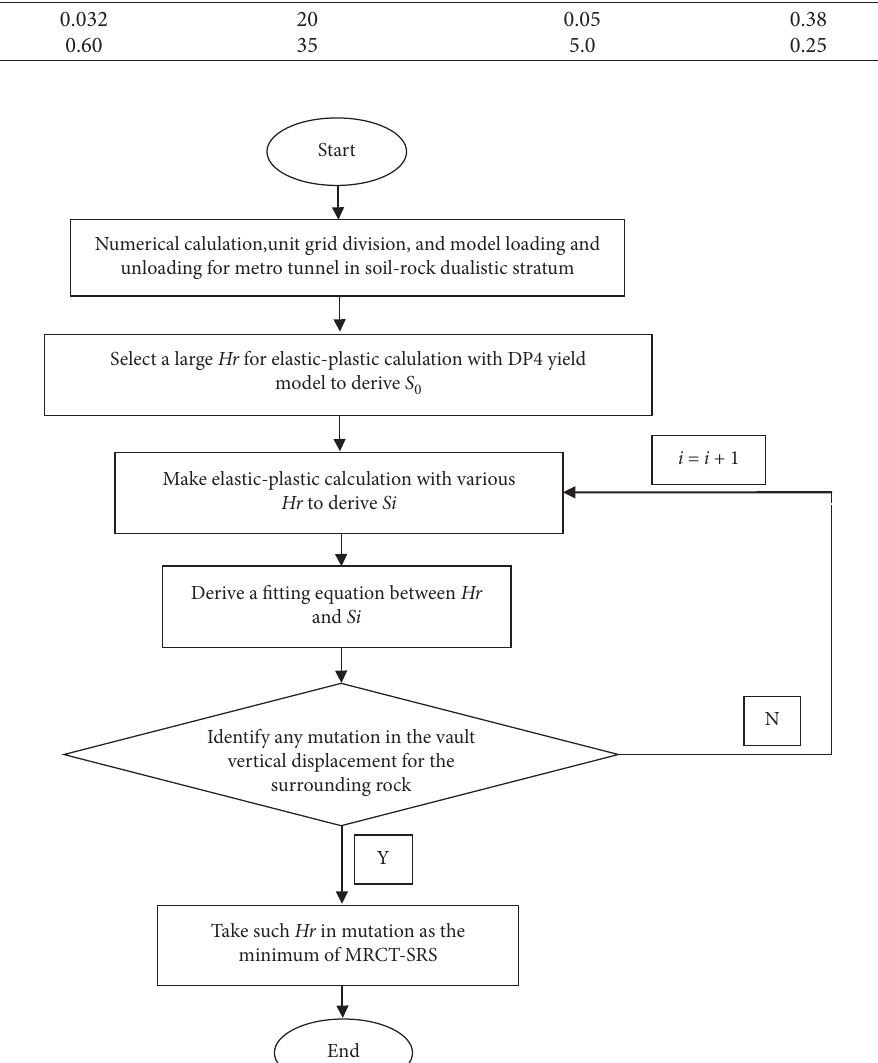
Figure 3: MRCT-SRS calculation process for metro